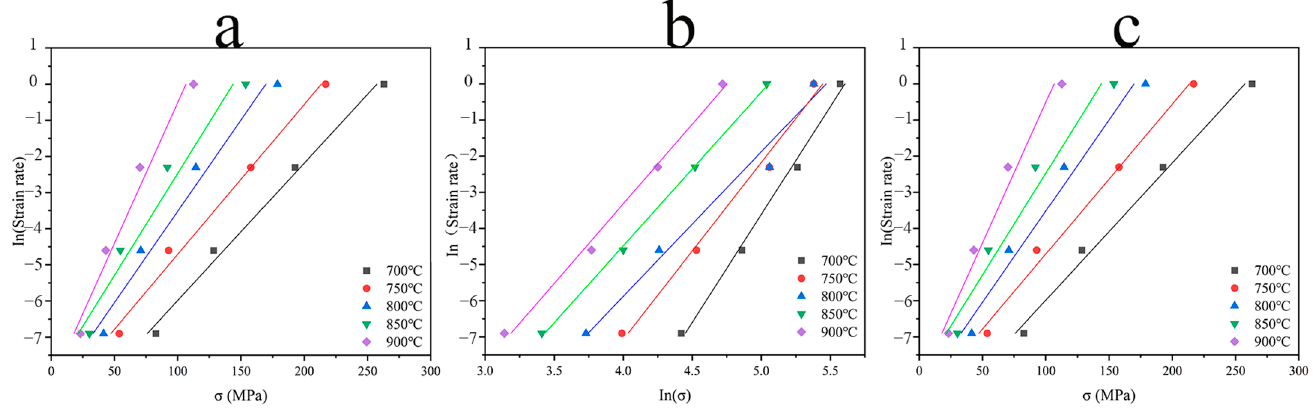
. ε ∼ σ p curve; ( b ) ln